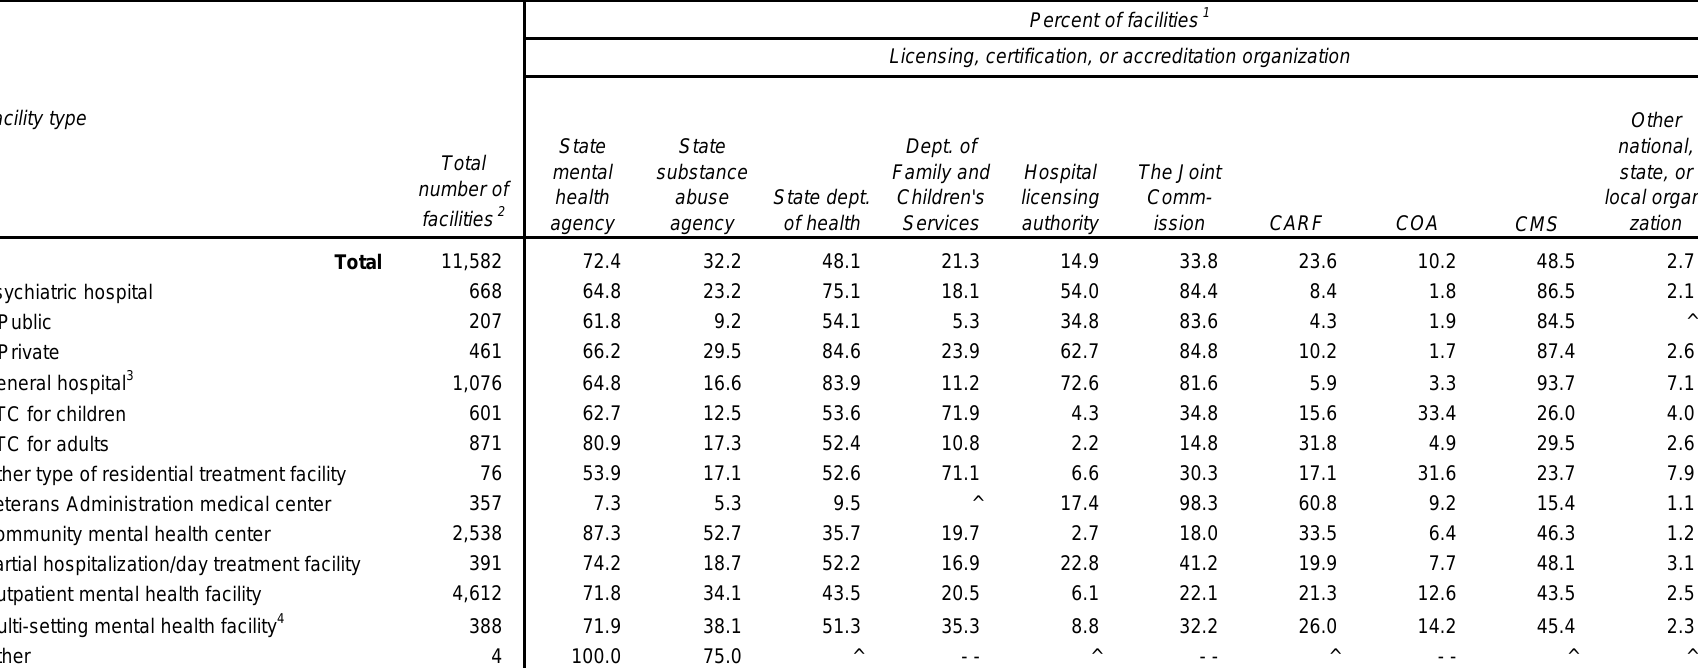
Table 2.11b. Mental health treatment facility licensing, certification, or accreditation, by facility type: Percent,